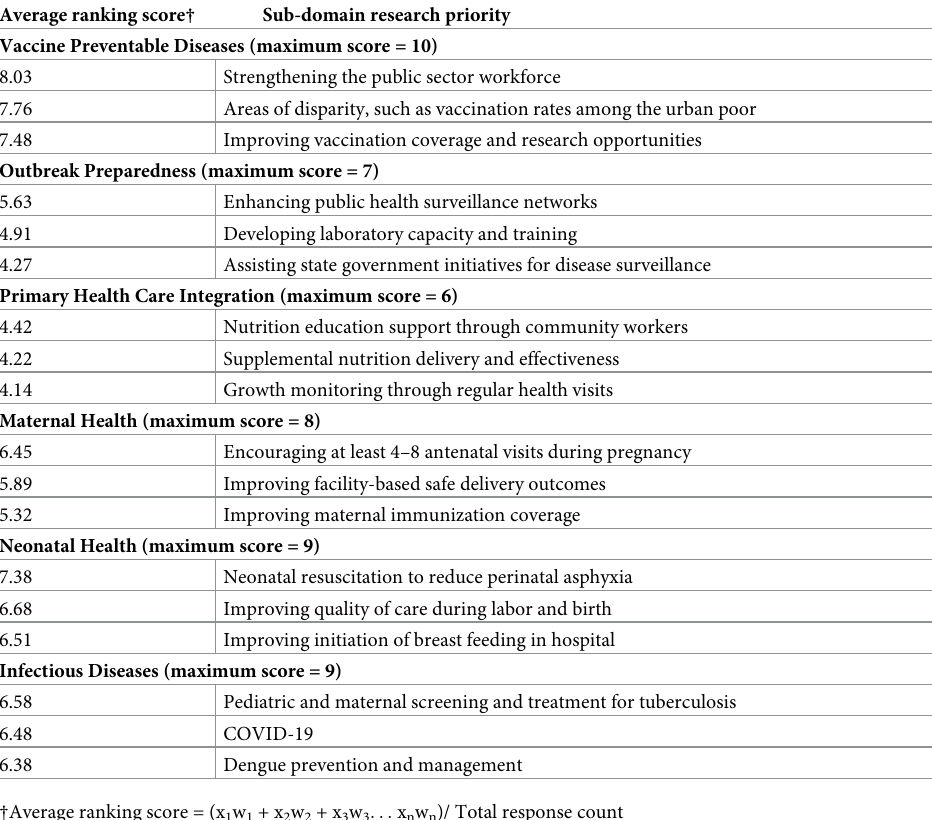
Table 2. Top 3 ranked research priorities across each domain, by average ranking